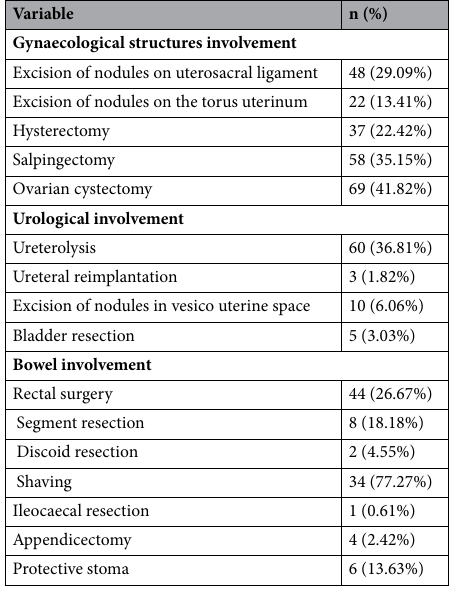
Table 2. Surgical procedures and pelvic structures